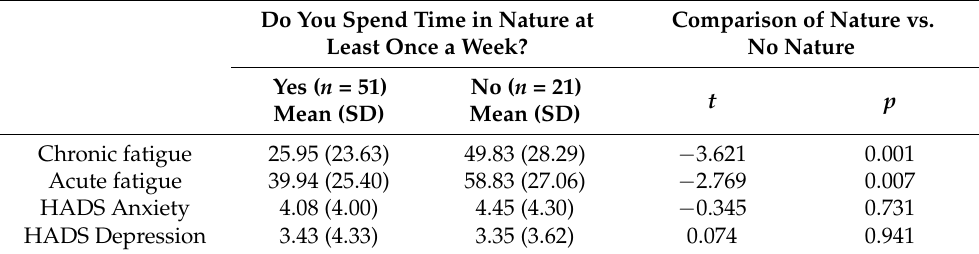
Table 4. Comparison of key outcome variables between participants who made weekly visits to nature, and those who did not. The results for chronic and acute fatigue remain significant after applying a Bonferroni correction changes α to 0.05 ÷ 4 = 0.0125. Do You Spend Time in Nature at Comparison of Nature vs. Least Once a Week? No